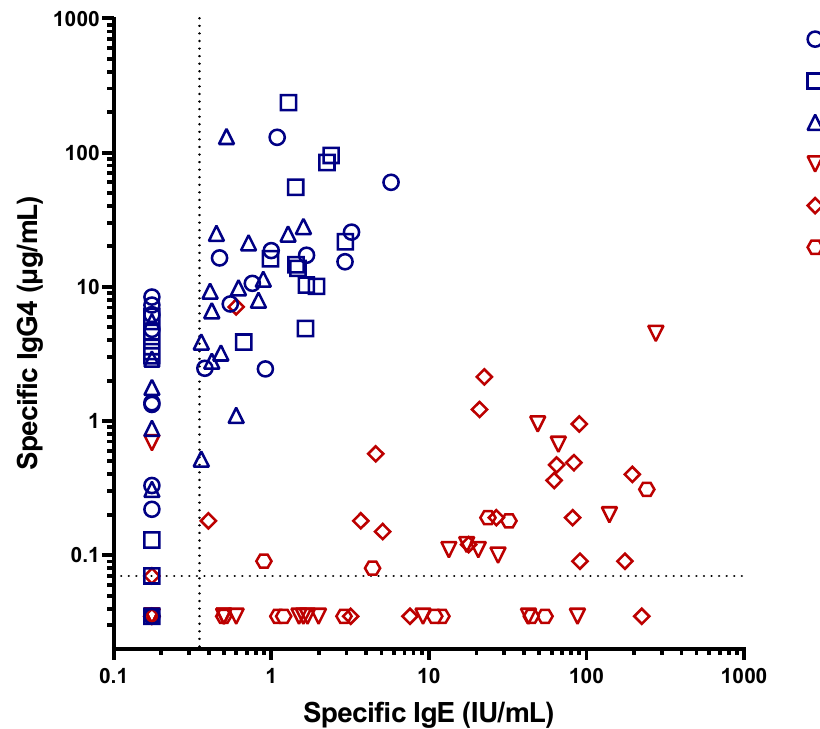
Figure 2. IgE and IgG4 to peanut and milk proteins (Adapted from Wilson et al. [23]).